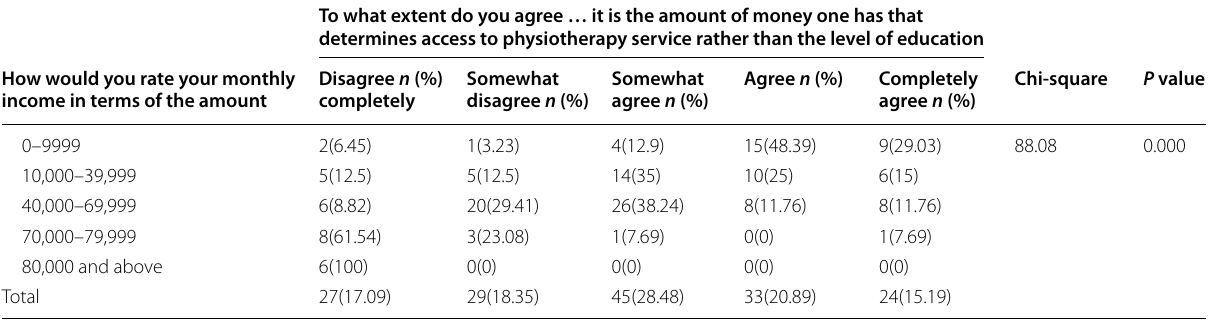
Table 7 Assessment of the association of the monthly income and access to physiotherapy services by patients and PWD (n